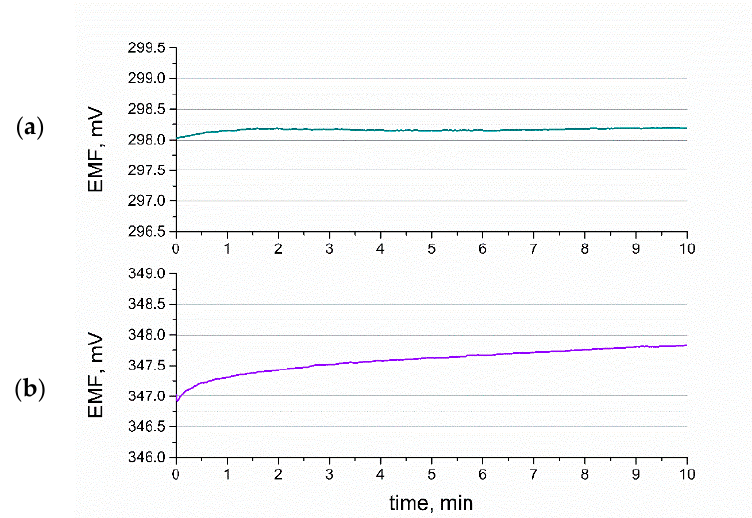
Figure 12. Potentiometric response of ( a ) GCD/RuO 2 •xH 2 O/K + -ISM electrode and ( b ) GCD/RuO 2 /K + -ISM electrode during first 10 min of measurement.